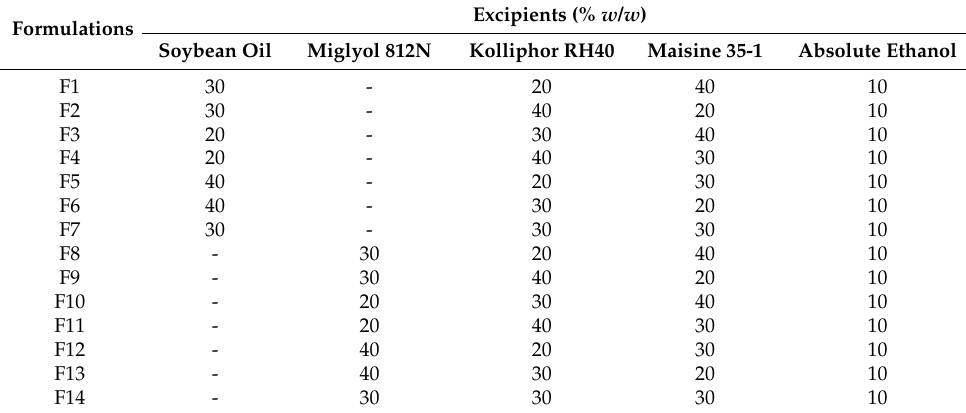
Table 2. Composition of self-nanoemulsifying drug delivery system (SNEDDS) formulations that were operated by D-optimal design using Umetric modeling and design (MODDE)